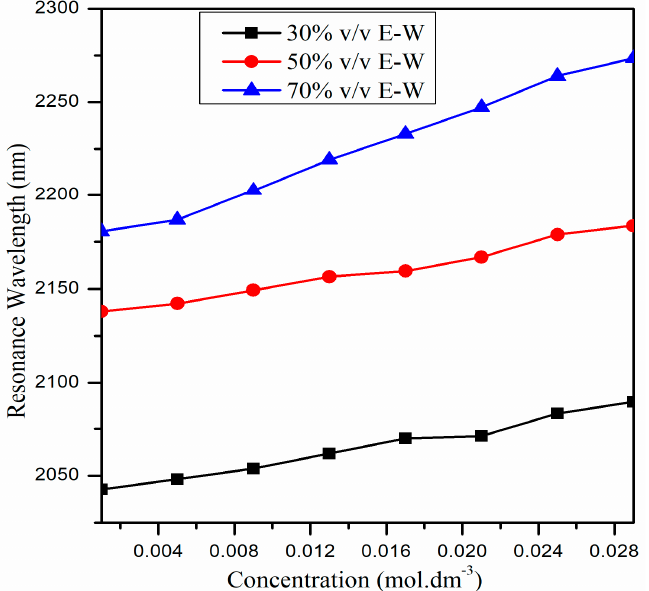
Figure 13. Variation in the resonance wavelength with the concentration of CIP hydrochloride for the proposed ITO-coated U-shaped LMR sensor. proposed ITO-coated U-shaped LMR